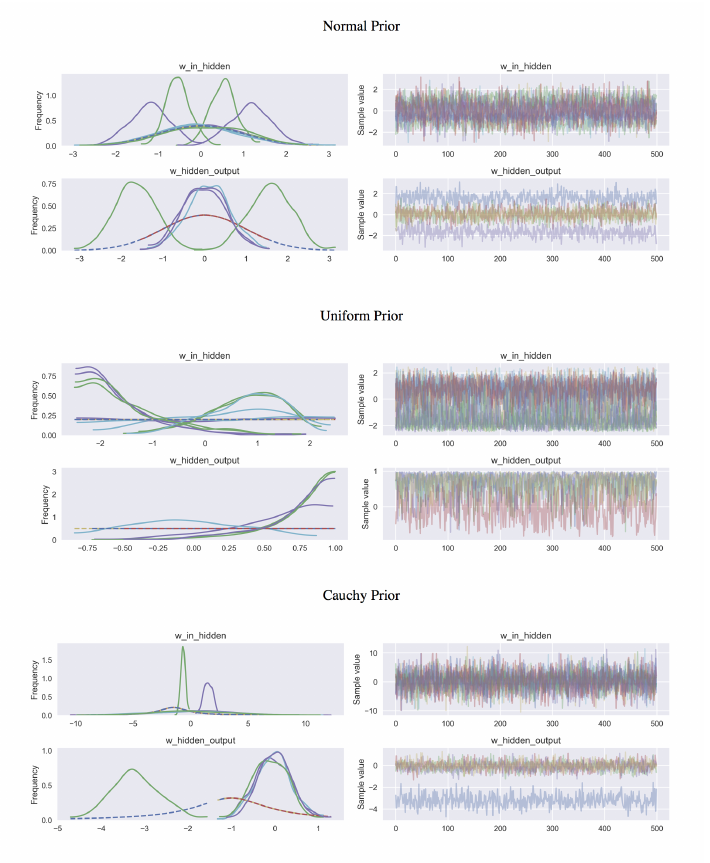
Figure 3. EffectsofDifferentPriorsonPosteriorinaSimulatedBinaryClassification. Note,here,thesimulated posterior inferences were based on a simple three layer Bayesian neural network with five units in the hidden layer on a binary classification problem. Left panel of Figure 3 reflects how prior, i.e., denoted as red and blue dotted lines, transformed to the weight posterior, i.e., identified as green and light blue lines. The right panel of Figure 3 demonstrates the sampling value of yielded weight posterior, based on 500 posterior samples. Reflected by the separateness of yielded weight posterior, it is clear that Cauchy prior achieved the most discriminability compare to other two priors, e.g., Normal and Uniform